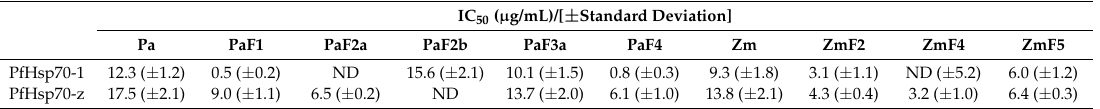
Table 3. Comparative IC 50 inhibition of P. angolensis and Z. mucronata extracts on PfHsp70-1 and PfHsp70-z chaperone activities.